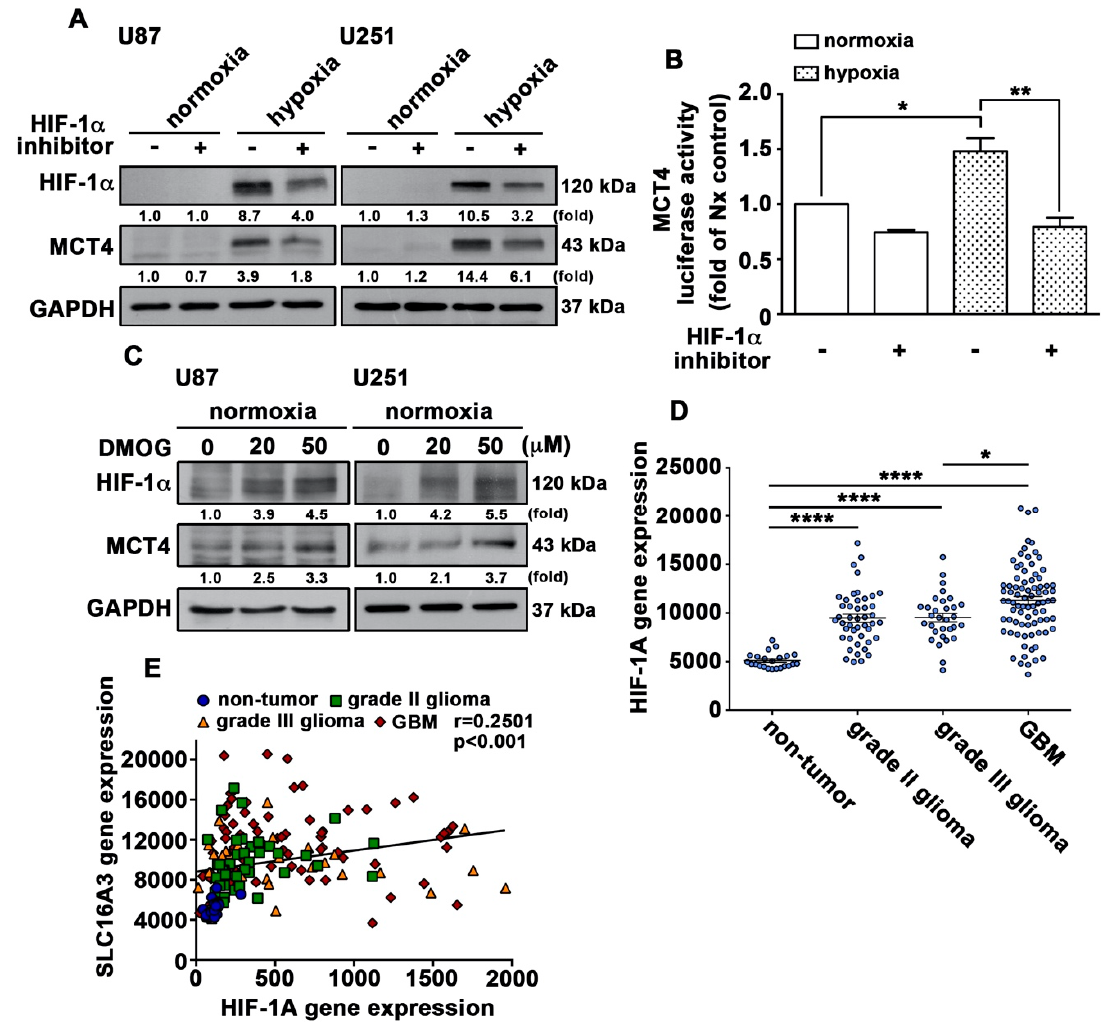
Figure 5. HIF-1 α is involved in hypoxia-induced MCT4 expression. ( A ) U87 and U251 cells were treated with the HIF-1 α inhibitor (10 µ M) for 30 min and were exposed to hypoxic conditions (1% O 2 ) for another 24 h. ( B ) U251 cells were transfected with MCT4 luciferase reporter plasmids for 24 h and were treated with the HIF-1 α inhibitor (10 µ M) for 30 min and were then exposed to hypoxic conditions (1% O 2 ). Firefly luciferase activity was measured after 24 h, and the results were normalized to renilla luciferase activity. Two-way ANOVA with a post-hoc Bonferroni test was used to examine the significance of the mean. * p < 0.05 compared with the normoxia control group. ** p < 0.01 compared with the hypoxia-only group. Quantitative data are presented as the mean ± S.E.M. ( n = 3). ( C ) U87 and ALTS1C1 cells were treated with DMOG (20, or 50 µ M) for 24 h. HIF-1 α and MCT4 protein expressions were determined using western blotting. ( D ) mRNA levels of HIF-1 α in patient specimens from the human glioma microarray dataset GSE4290. One-way ANOVA with a post-hoc Bonferroni test was used to examine the significance of the mean. * p < 0.05 GBM compared with grade III glioma. **** p < 0.0001 compared with non-tumor. ( E ) Pearson’s correlation analysis between HIF-1 α and MCT4 gene expressions in the human glioma microarray dataset GSE4290 (r = 0.2501, p <